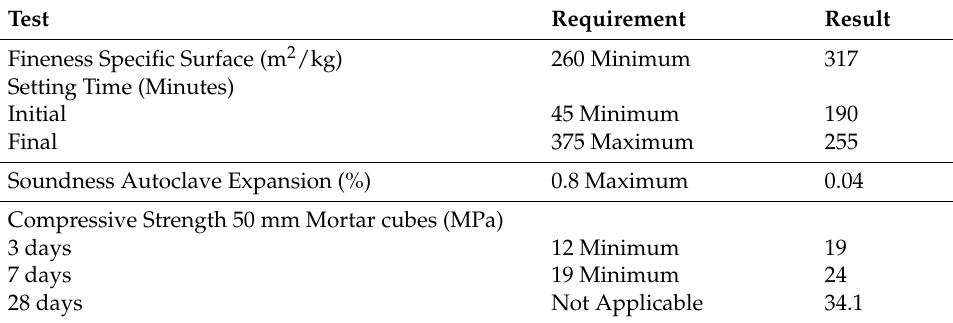
Table 1. Physical properties of Portland cement